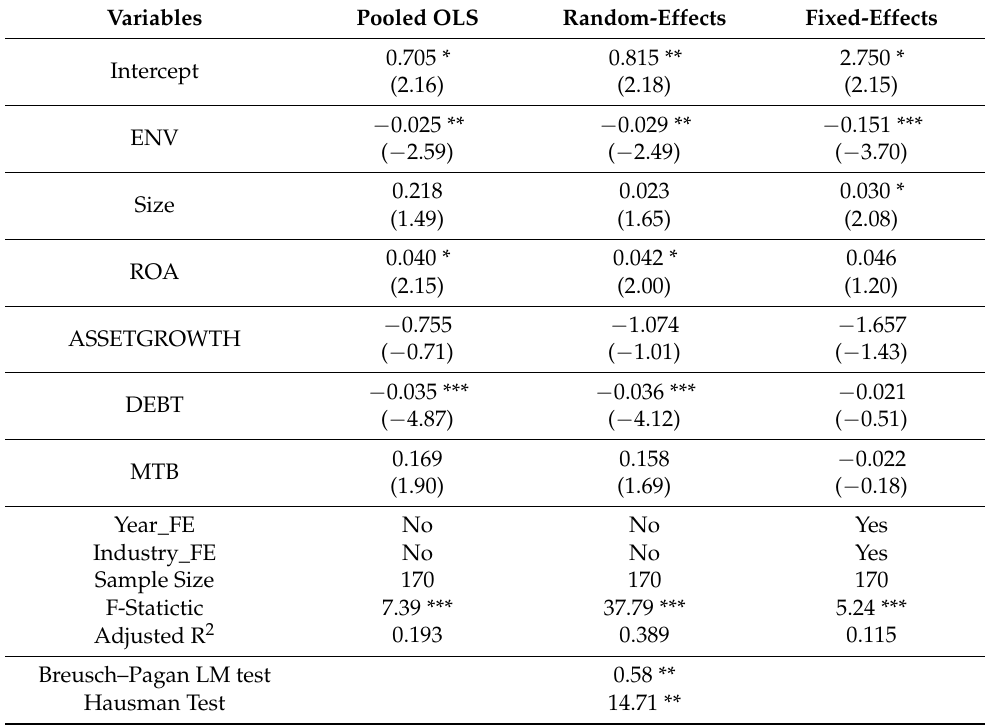
Table 4. The impact of environmental disclosures on stock